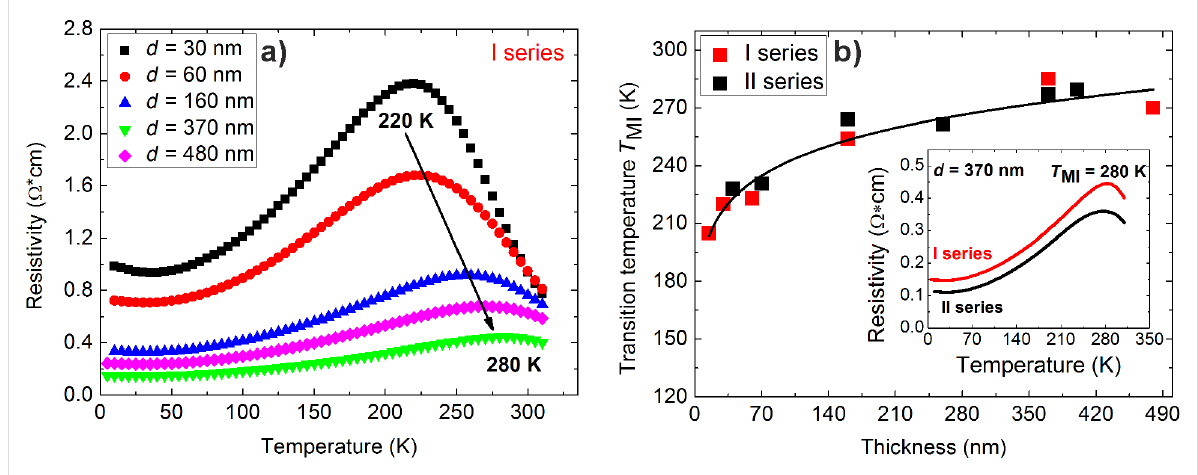
Figure 3: (a) Resistivity dependence on temperature for nanostructured LSMO films with thickness in the range of 30–480 nm grown on Al 2 O 3 sub- strates; (b) T MI dependence on film thickness for both deposition series, black line is a guide for the eye. Inset – resistivity dependence on tempera- ture for 370 nm thick LSMO films of the I and II series.